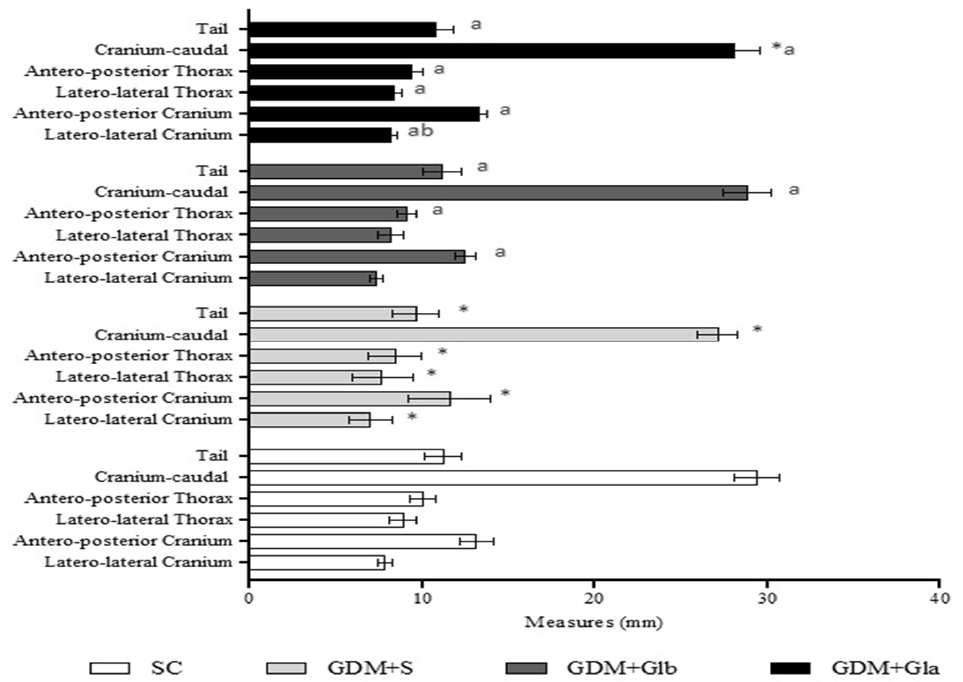
Figure 4. Fetal measurements. GDM-STZ treated with Ganoderma lucidum . SC (0.9% saline solution), GDM+S (Diabetic+saline solution 0.9%), GDM+Glb (Diabetic + 100 mg/kg/day of Ganoderma lucidum from gestation day 1 to 19), GDM+Gla (Diabetic + 100 mg/kg/day of Ganoderma lucidum from gestation day 9 to 19). Data are presented as mean ± SD ( n = 8). (*) p < 0.05 in comparison to SC group, (a) in comparison to the GDM+S group, (b) in comparison to the GDM+Glb group; One-way ANOVA, followed by Tukey–Kramer’s